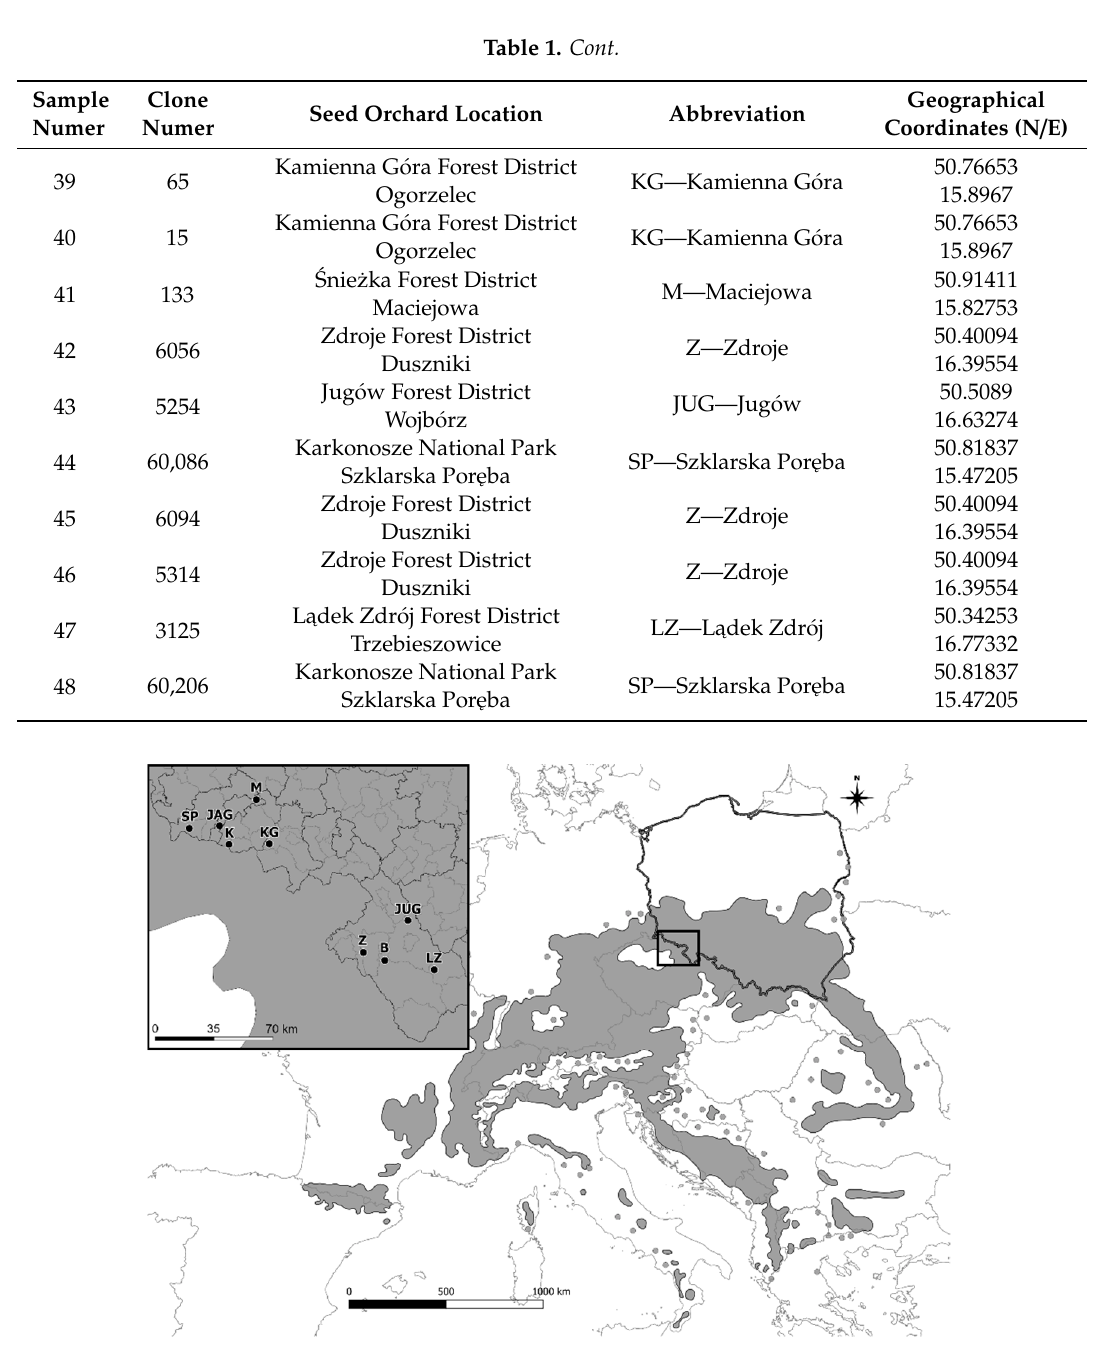
Figure 1. Distribution of Abies alba (source Euforgen [30]) and location of the seed orchards.